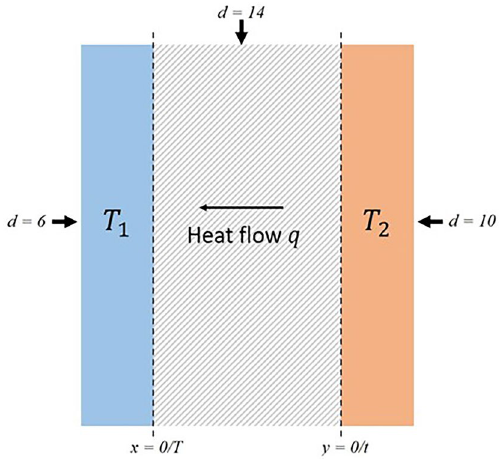
Figure 3. Temperature field values depending on time.